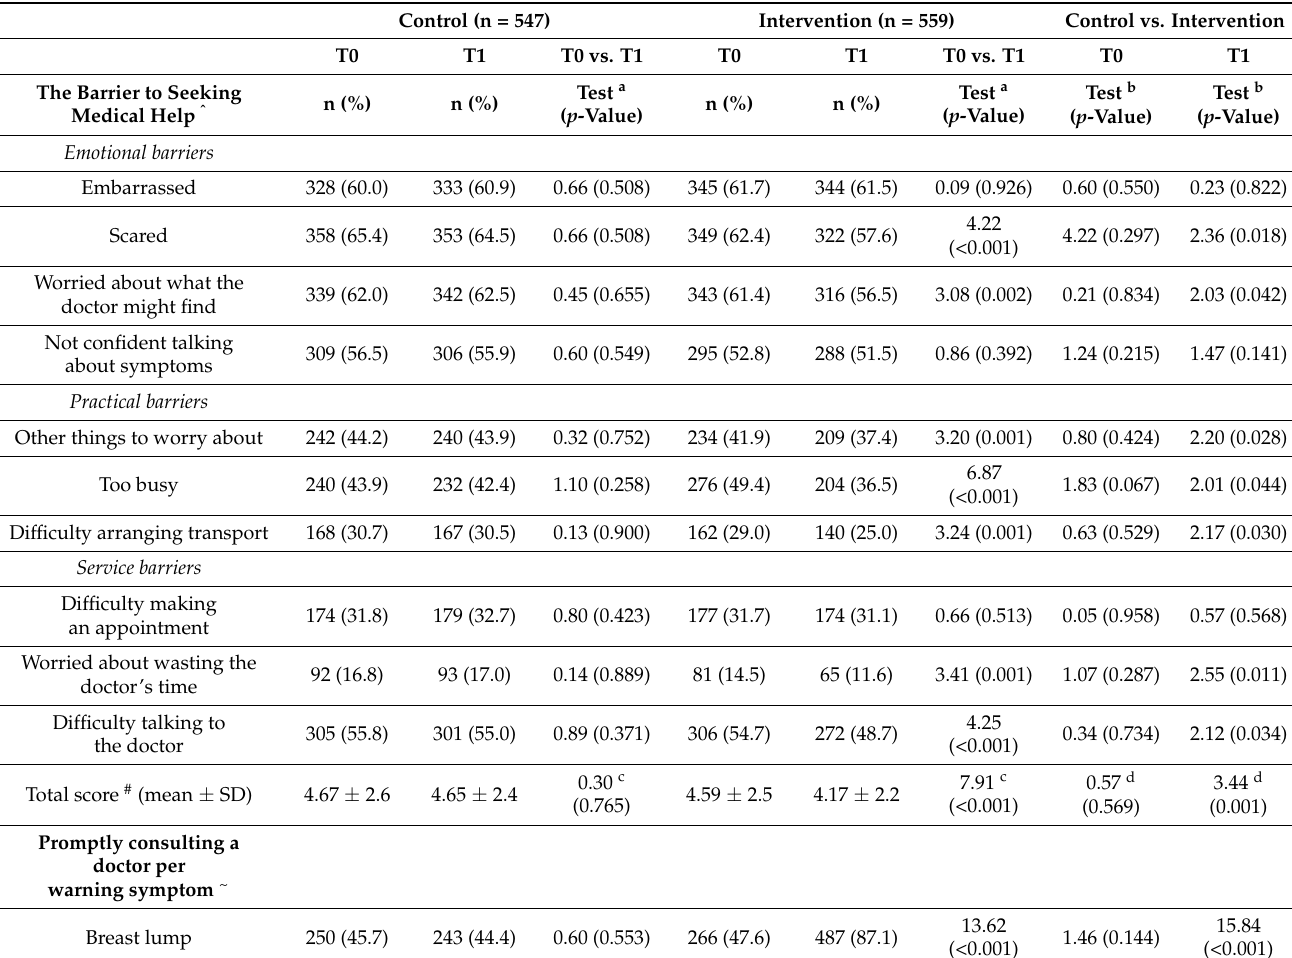
Table 3. Comparison of barriers to seeking medical help and anticipated time to consult a doctor for breast cancer warning symptoms between groups at baseline (T0) and four weeks later (T1) ( N = 1106). Control (n = 547) Intervention (n = 559) Control vs.